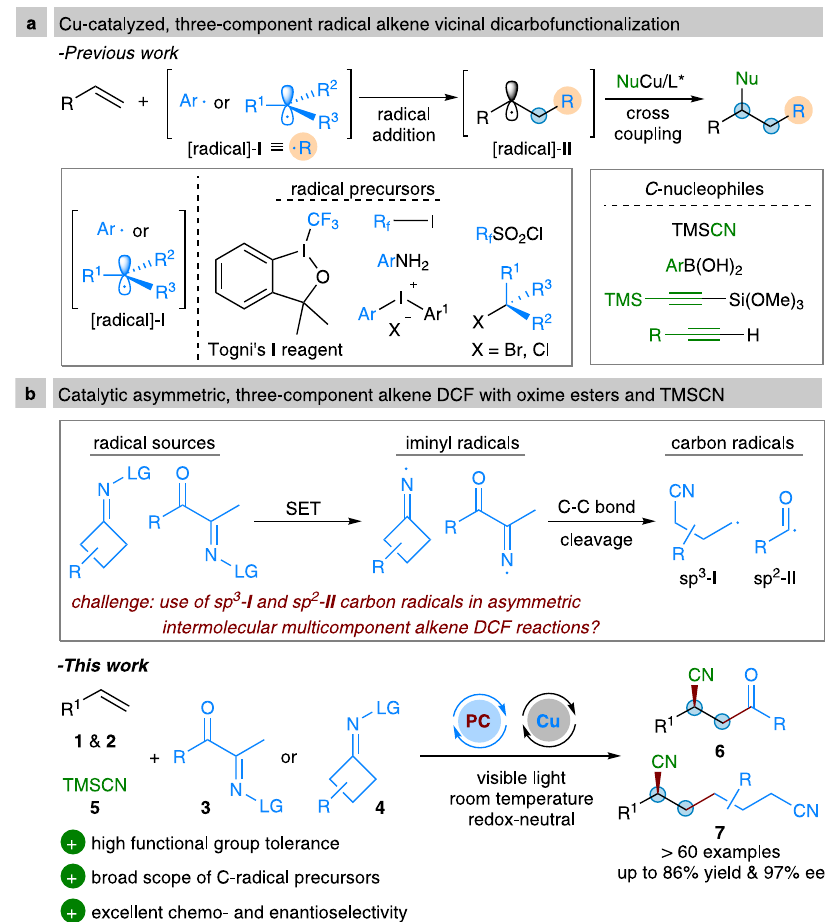
Fig. 1 Catalytic asymmetric three-component radical dicarbofunctionalization reactions of alkenes. a Cu-catalyzed, three-component radical alkene vicinal dicarbofunctionalization. b Catalytic asymmetric, three-component alkene DCF with oxime esters and